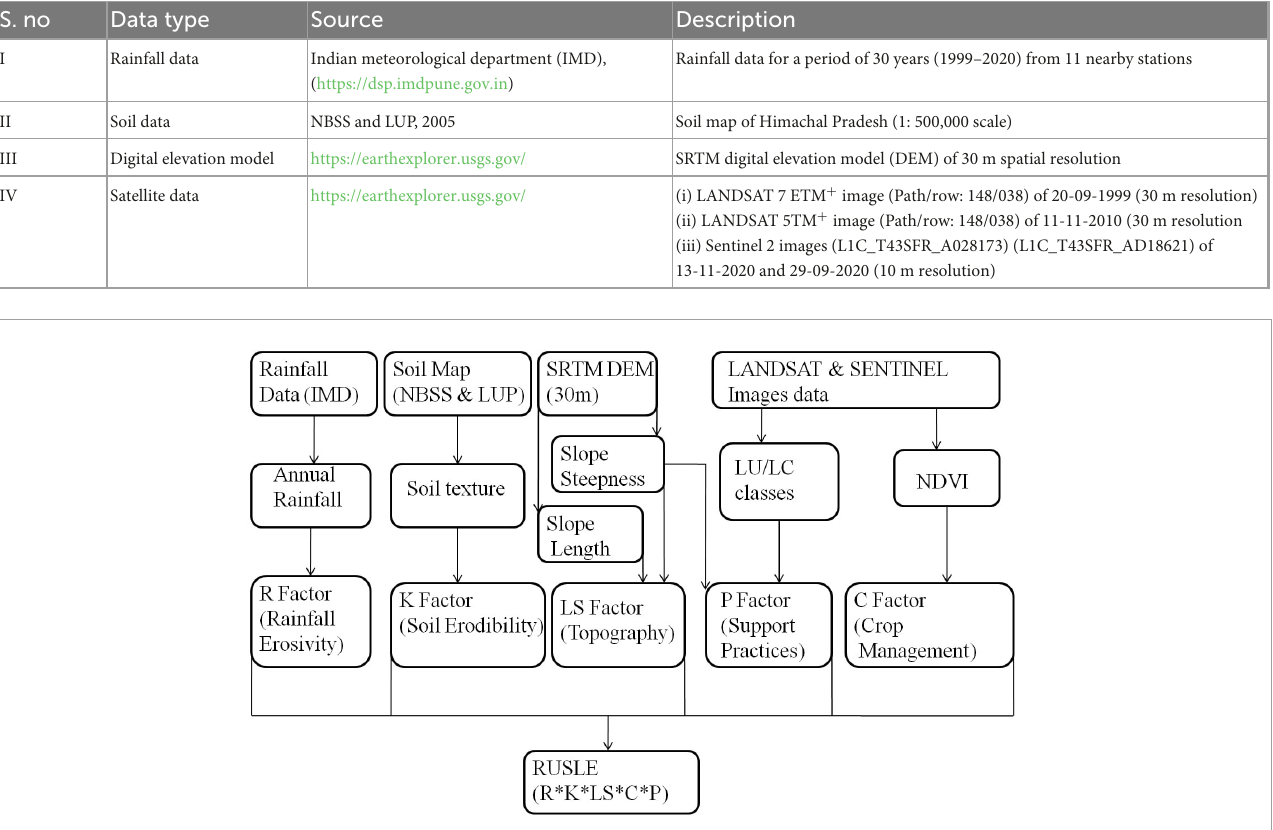
FIGURE2 Flow chart demonstrating the methodology adopted for RUSLE